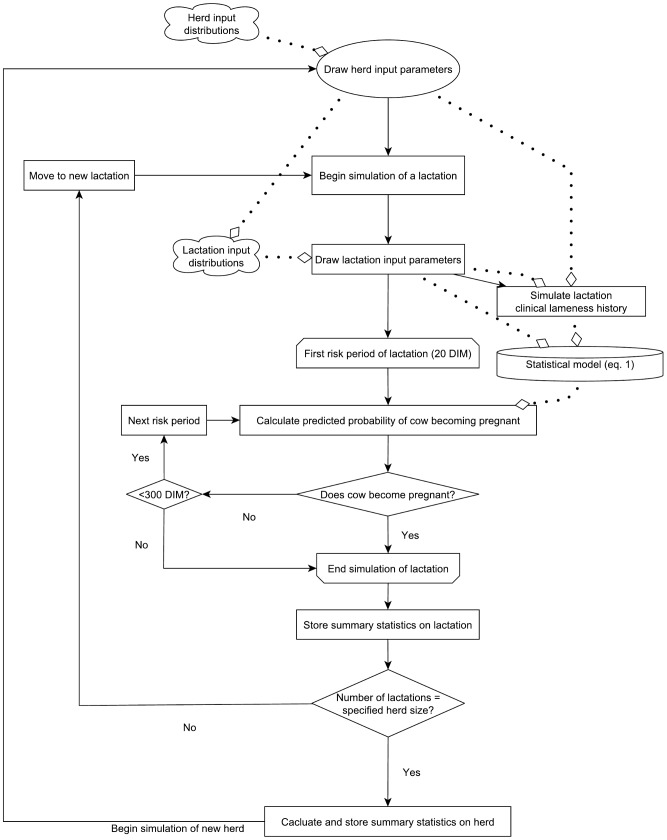
Structure of the simulation model used for probabilistic sensitivity analysis.Solid black lines indicate process flow, dotted lines indicate that information from the source of the line is used in the step of the process to which the line leads (denoted by a diamond).